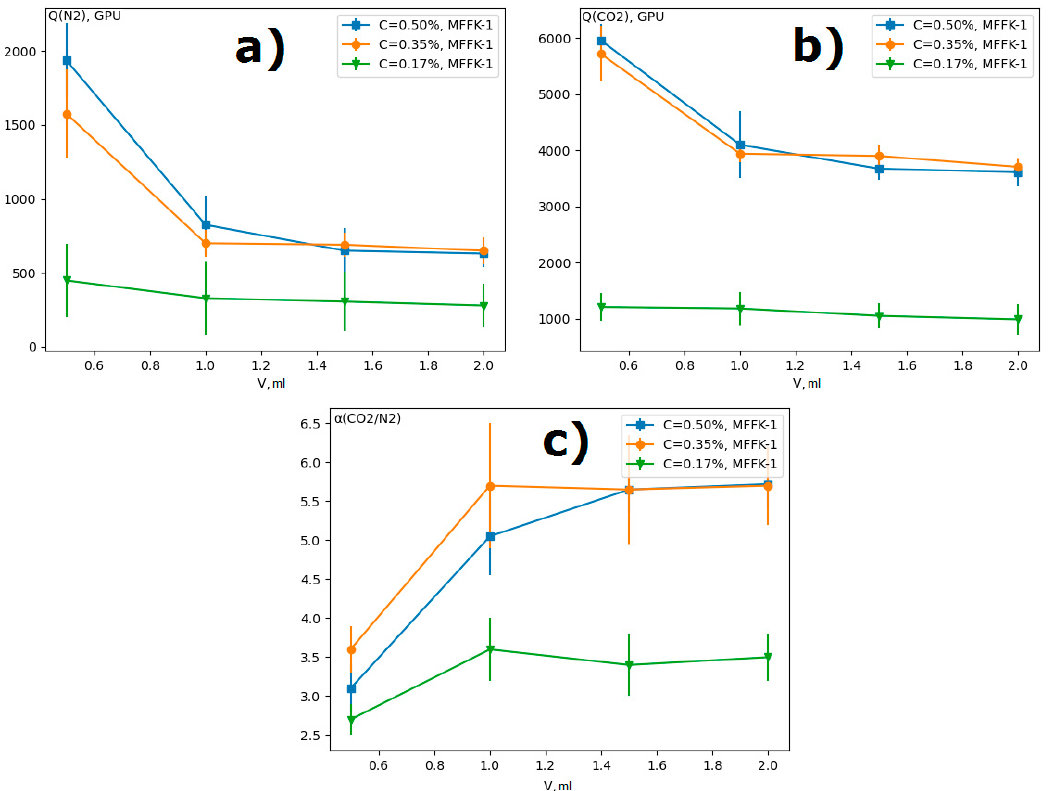
Figure 3. Gas transport properties of composite MFFK-1/PTMSP membranes obtained by applying PTMSP solutions of various concentrations, depending on the volume of the solution ( ω = 750 rpm): ( a ) N 2 permeance, ( b ) CO 2 permeance, ( c ) ideal CO 2 /N 2 selectivity.